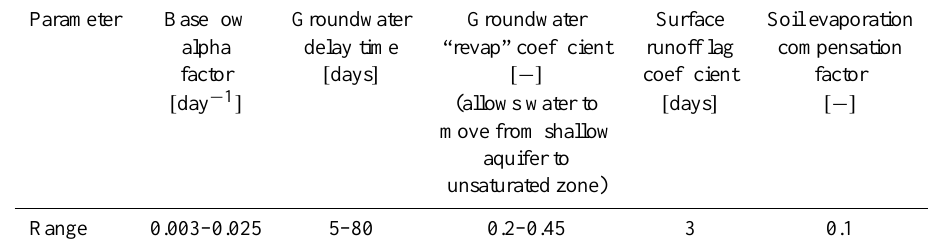
Table 2. Main calibration parameter values in the SWAT model. For detailed description of the parameters see Neitsch et al. (2004). Parameter